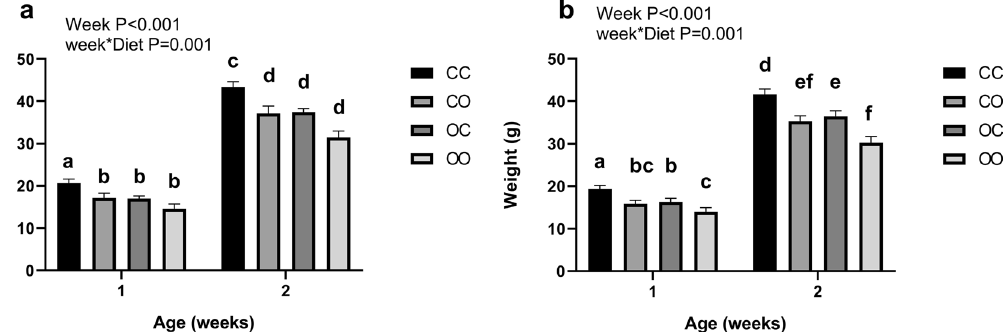
Figure 5. Offspring weekly weights pre-weaning. Values are for are mean and SEM. ( a ) Male offspring, ( b ) Female offspring. Four groups of cross-fostered offspring were studied: offspring exposed to a chow diet during pregnancy cross-fostered to a chow fed dam during lactation (CC, n 16) or a cafteria fed dam (CO, n 16), offspring exposed to a cafeteria diet during pregnancy cross-fostered to a chow fed dam during lactation (OC, n 16) or a cafeteria fed dam (OO, n 12). Some animals were excluded from the analysis due to assessment of extreme outliers or data missing. Effect of maternal diet vs time on weekly weight of the offspring was determined through repeated measures ANOVA and Bonferroni post hoc tests. In male offspring, effect of time ( P < 0.001), Diet * time ( P = 0.001) and post hoc test revealed CO, OC and OO to be significantly lighter than CC. In female offspring, effect of time ( P < 0.001), Diet * time ( P = 0.001), post hoc analysis identified CO, OC and OO to be significantly lighter than CC, and OC to be significantly higher than OO. Different superscript letters signify significant differences at the P < 0.05 level.